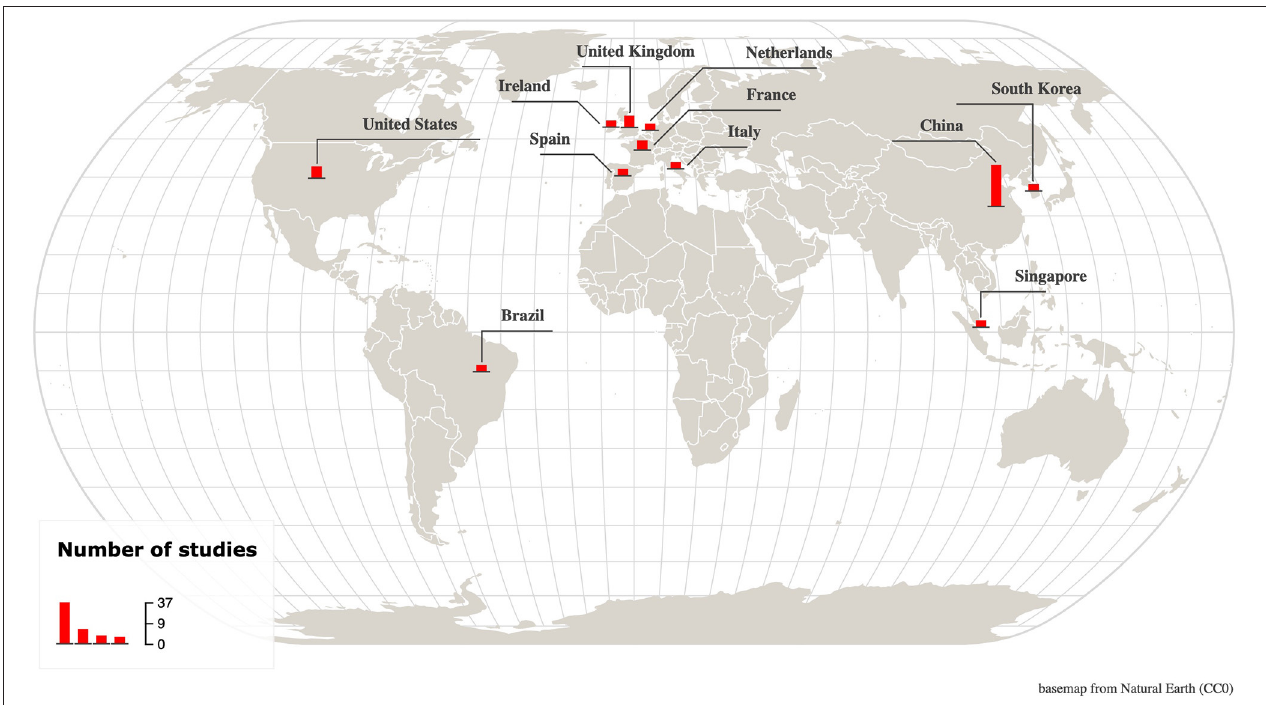
FIGURE 2 | Map showing the location and number of included studies. A total of 52 studies from 11 countries across 3 continents were included. Made with Khartis (